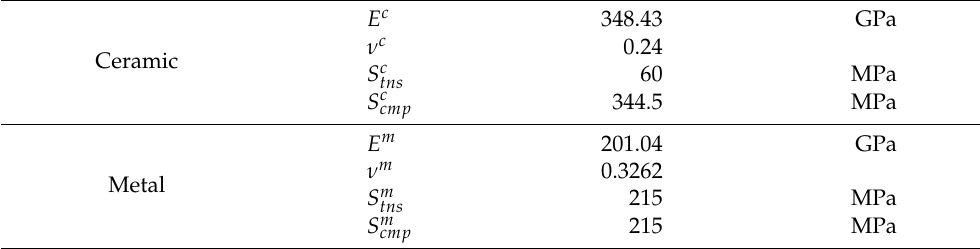
Table 7. Engineering material constants for Example